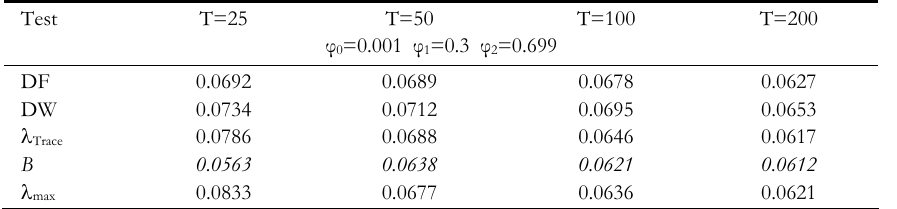
Proportions of rejects out of 5000 tests, nominal level